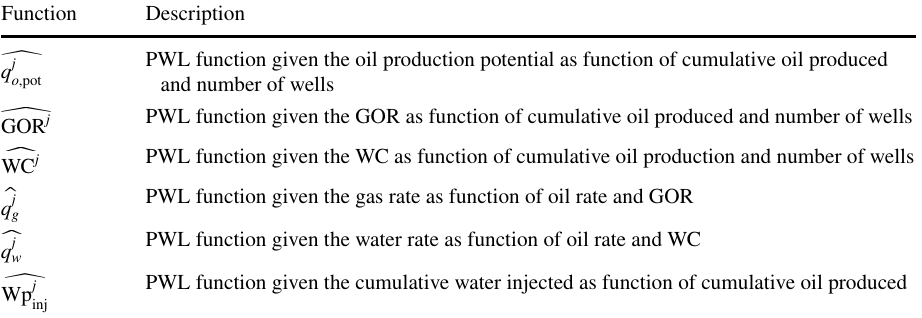
functions used in MILP